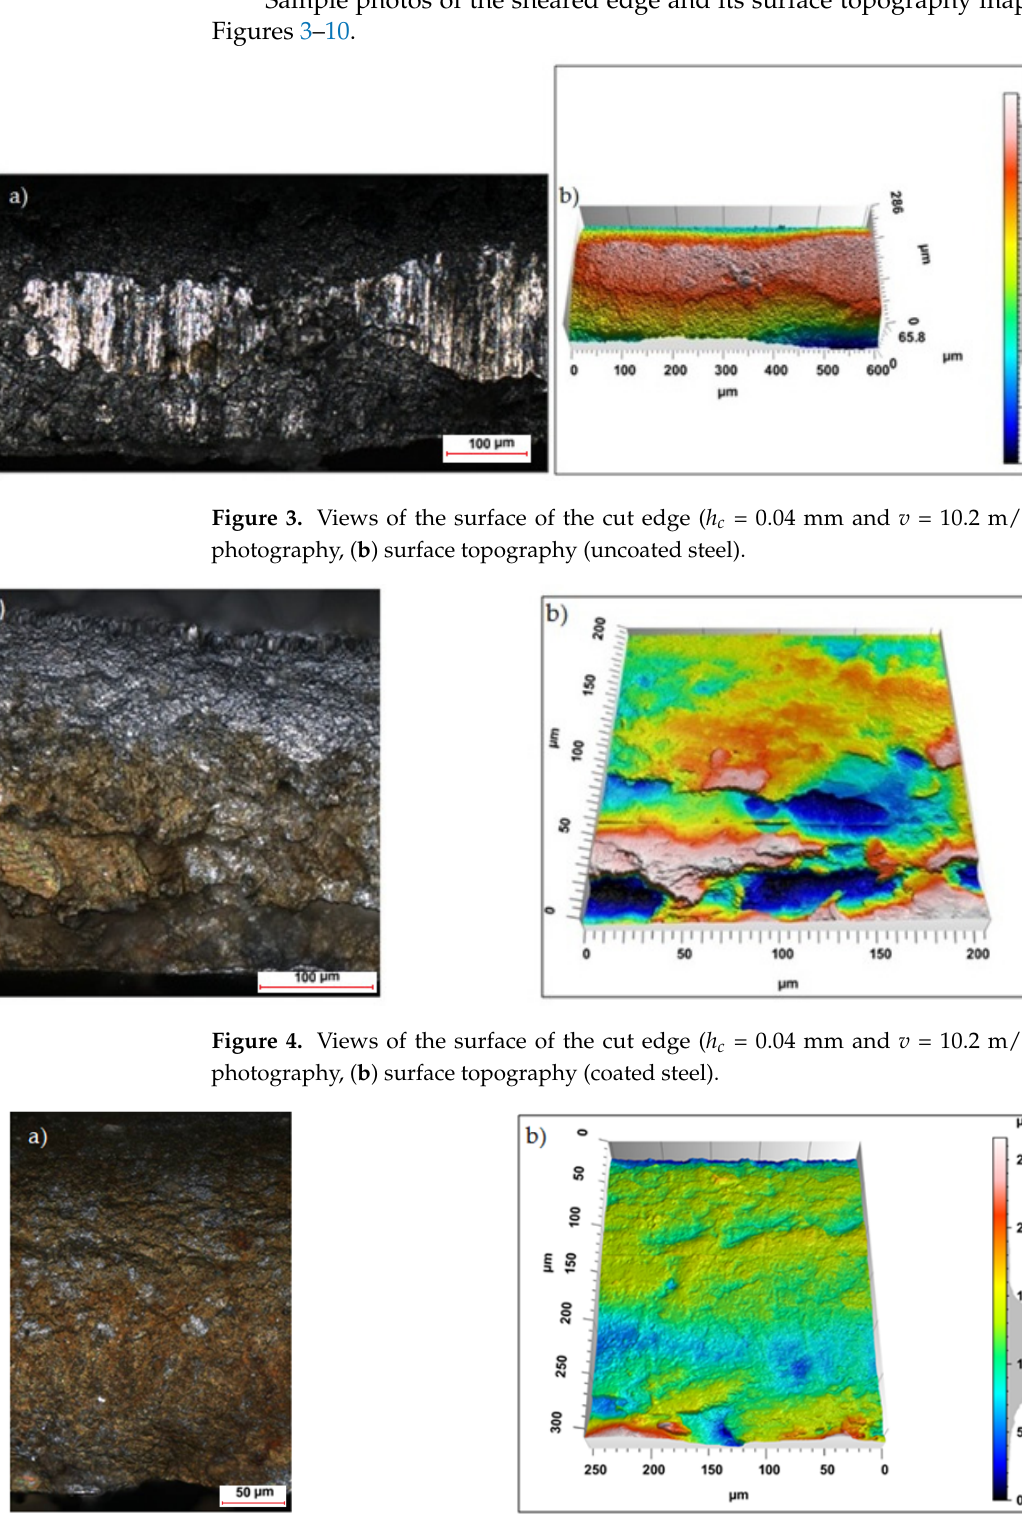
Figure 5. Views of the surface of the cut edge ( h c = 0.08 mm and v = 10.2 m/min): ( a ) surface photography, ( b ) surface topography (uncoated steel).